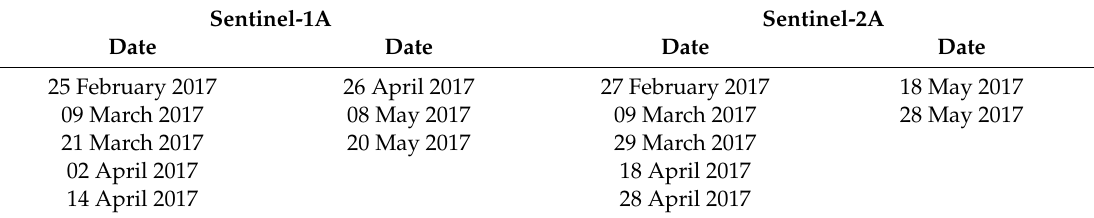
Table 1. Sentinel-1A and Sentinel-2A datasets used in this